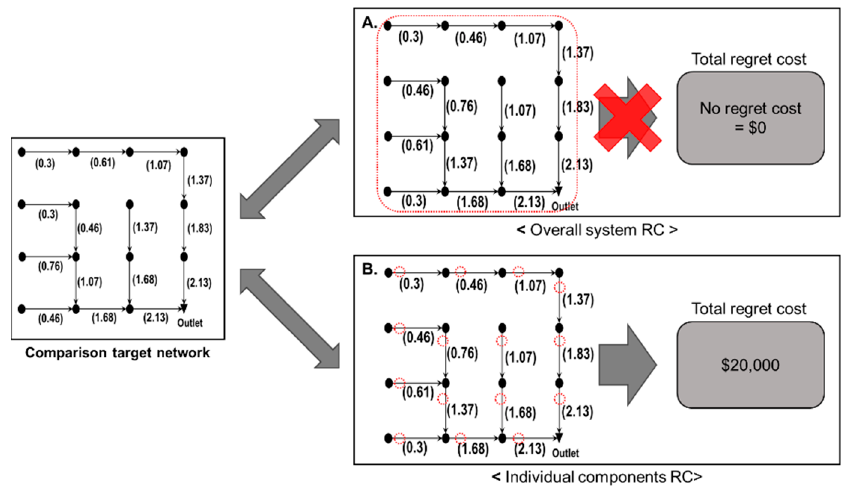
Figure 1. Schematic of regret cost (RC) concept at two levels. ( A ) Overall system; ( B ) individual components.